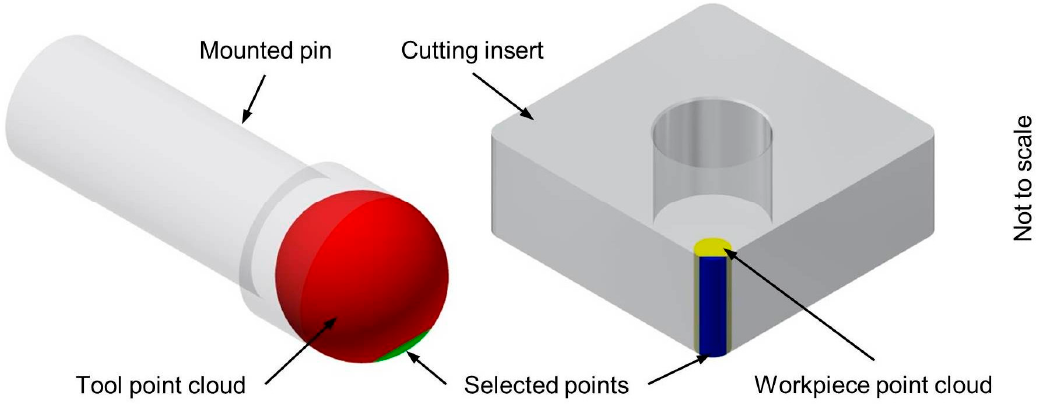
Figure 5. Schematic representation of the tool and workpiece areas relevant for simulated calculation.